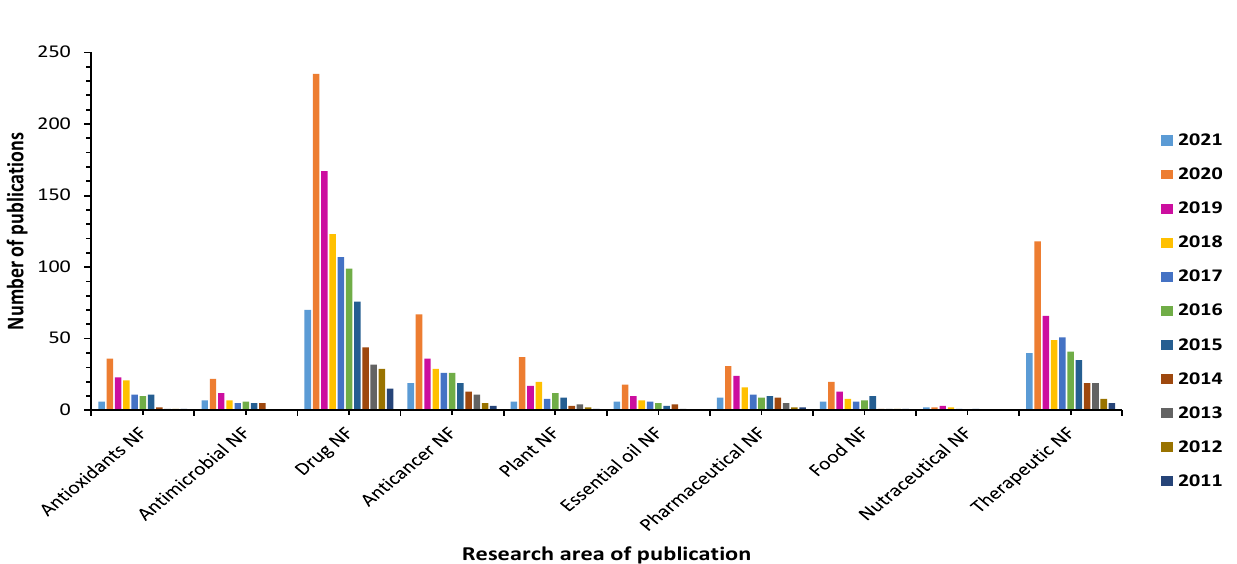
Figure 1. Graphical representation of number of publications from Web of Science in the field of antimicrobial, antioxidants, drug, anticancer, plant, essential oil, pharmaceutical food, nutraceutical and therapeutic nanoformulations from January 2011 to May 2021. NF = nanoformulations.